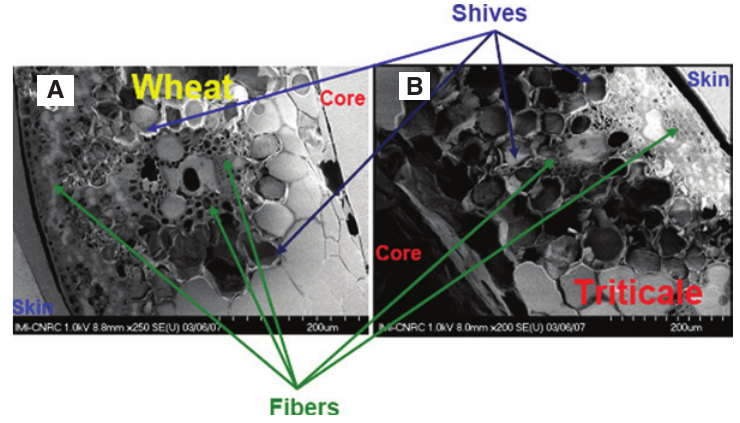
Figure 4 Cross-section SEM photos of wheat and triticale straws.